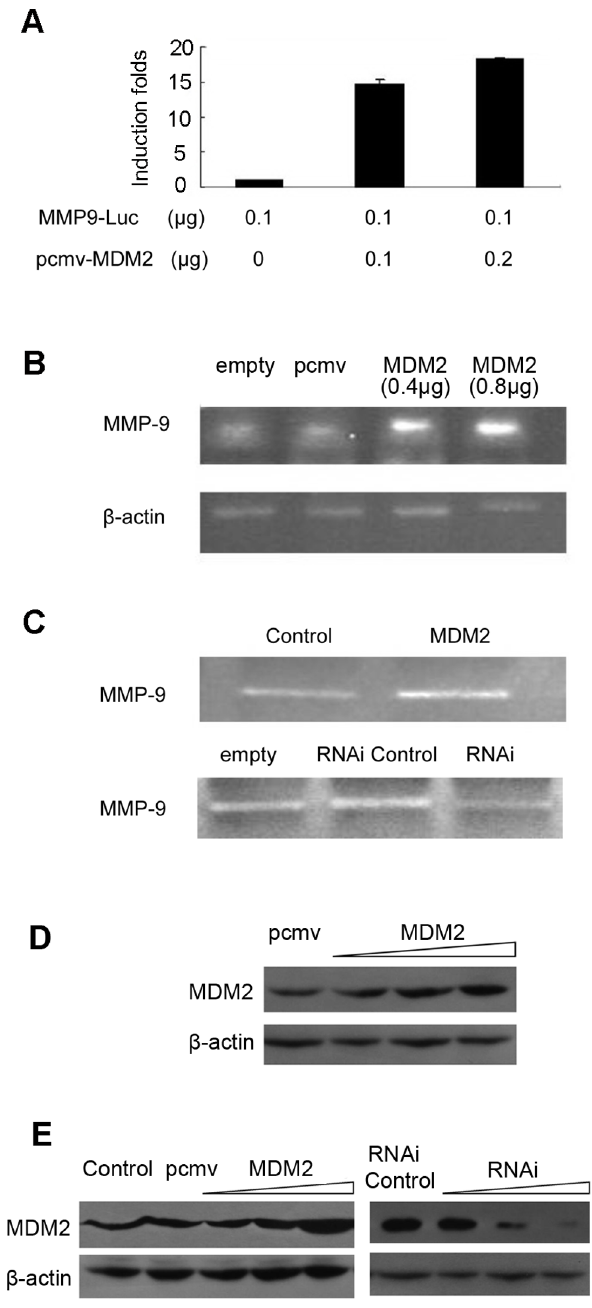
Figure 7. MDM2 upregulates MMP9 expression. (A) MCF-7 cells were transfected with MMP9-Luc reporter plasmids and pcmv-MDM2 expression plasmids for 24 h. Whole-cell lysates were utilized to detect luciferase activities, and b -galactosidase activities were used as an internal control for transfection efficiency. The results were obtained from three independent experiments. Data are expressed as the mean 6 SD. (B) Total RNA was isolated from MCF-7 cells transfected with pcmv-MDM2 expression plasmids or pcmv vectors to assay MMP9 mRNA levels using RT-PCR, normalized against b -actin. Images are representative of three independent experiments. (C) MMP9 activity was detected using gelatin zymography in MDA-MB-231 cells that over- or under-expressed MDM2 (plasmid or siRNA transfection) and control cells. (D) The levels of MDM2 protein were detected using Western blot analysis in MDF-7 cells transfected with MDM2 expression plasmids and control vectors. b -actin levels served as internal control. (E) The levels